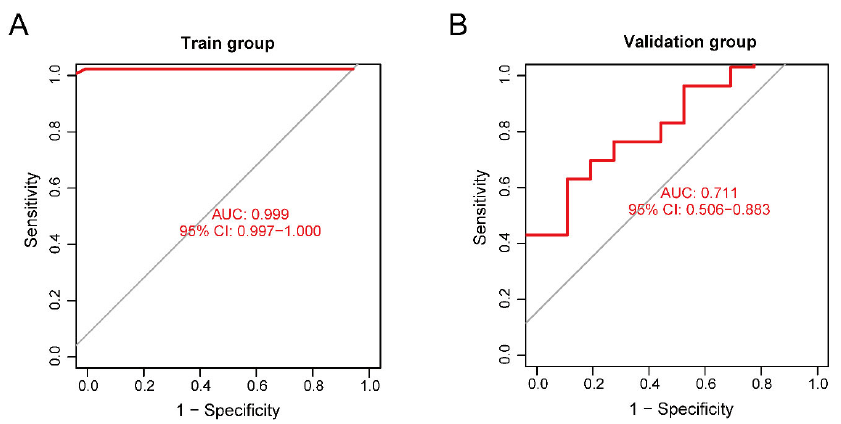
Figure 8. ( A ) Receiver operating characteristic (ROC) curve of the training set. ( B ) ROC curve of the validation set.